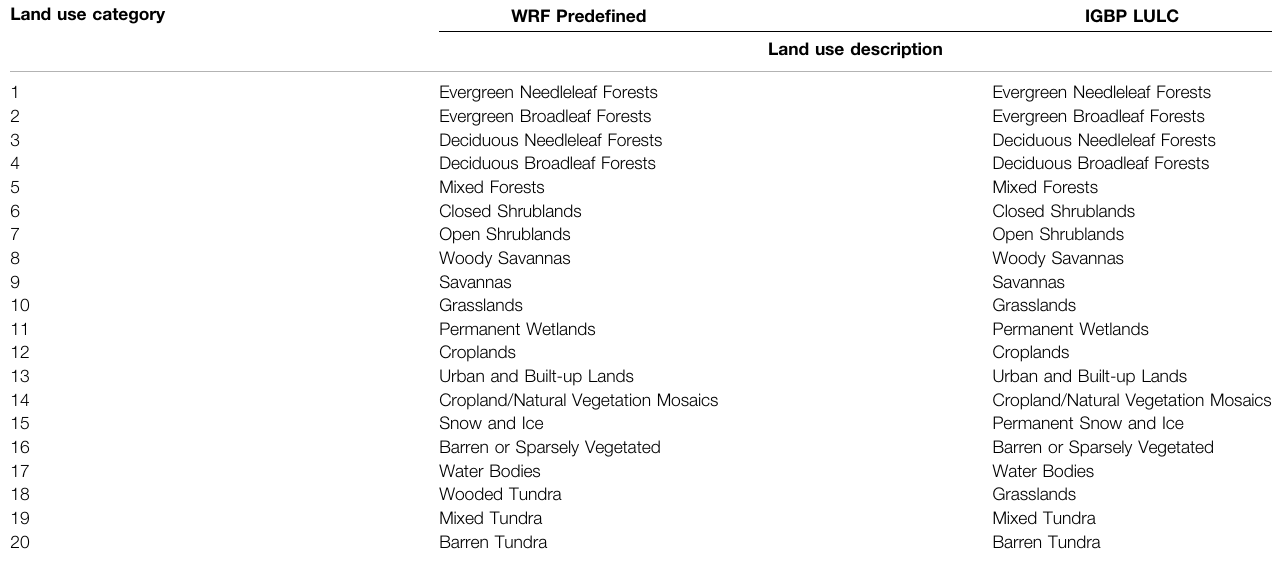
TABLE 1 | Pre-de fi ned WRF LULC and IGBP